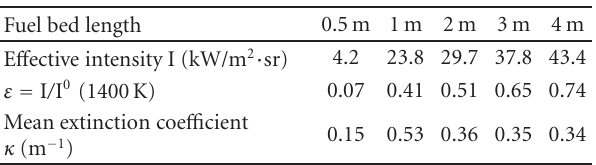
Table 2: E ff ective radiative properties of the flame. WS are used as fuel, with a fuel load of 1kg/m 2